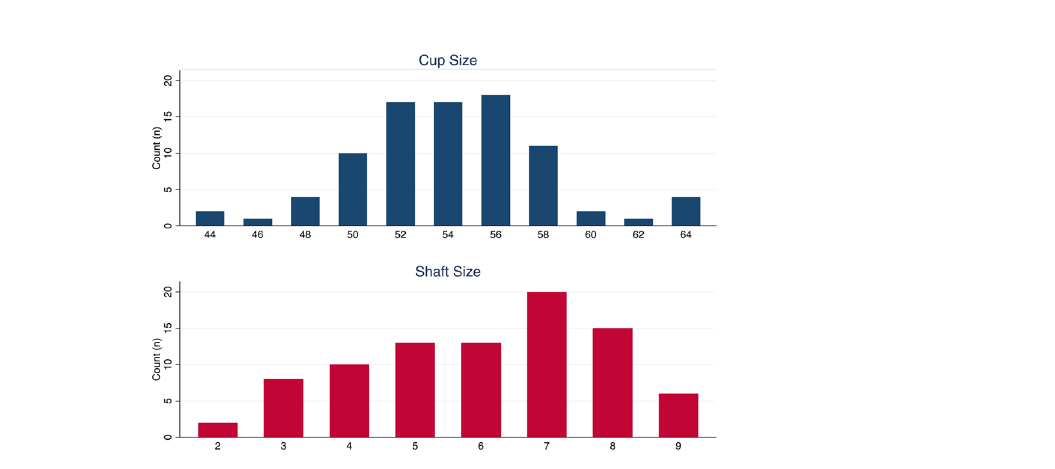
Figure 4. Distribution of cup and shaft sizes of the study